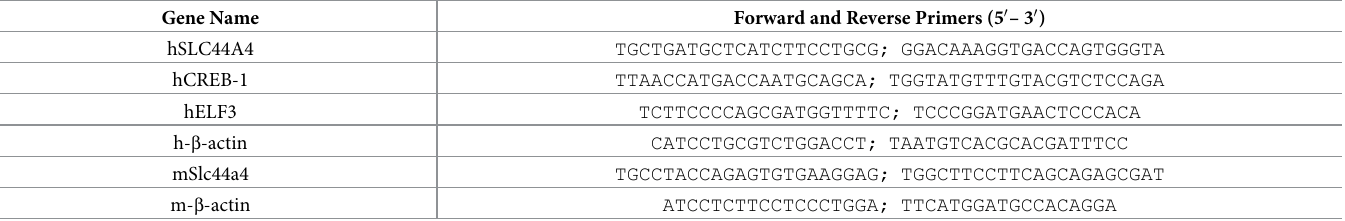
Table 1. Primers used for real-time PCR analysis. Gene